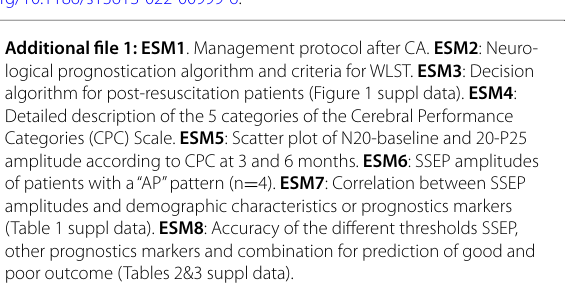
(Table 1 suppl data). ESM8 : Accuracy of the different thresholds SSEP, other prognostics markers and combination for prediction of good and poor outcome (Tables 2&3 suppl